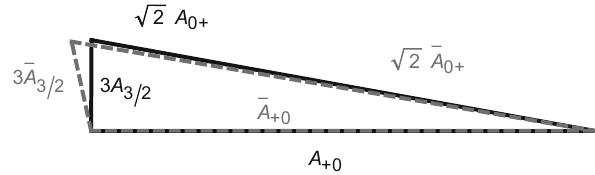
Fig. 10 Illustration of the isospin triangles for the charged B → π K decays with | A 3 / 2 | = | ¯ A 3 / 2 |